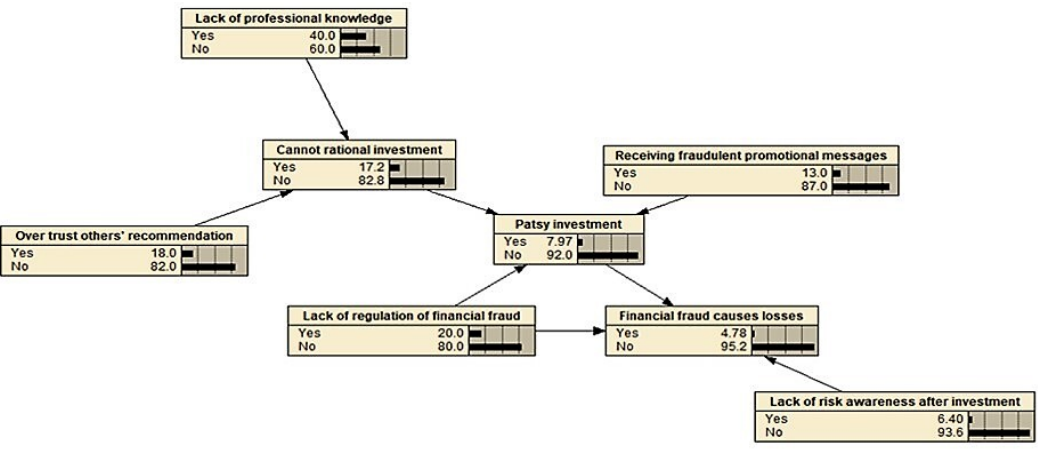
Figure 8. The Bayesian network of fund ‐ raising fraud.